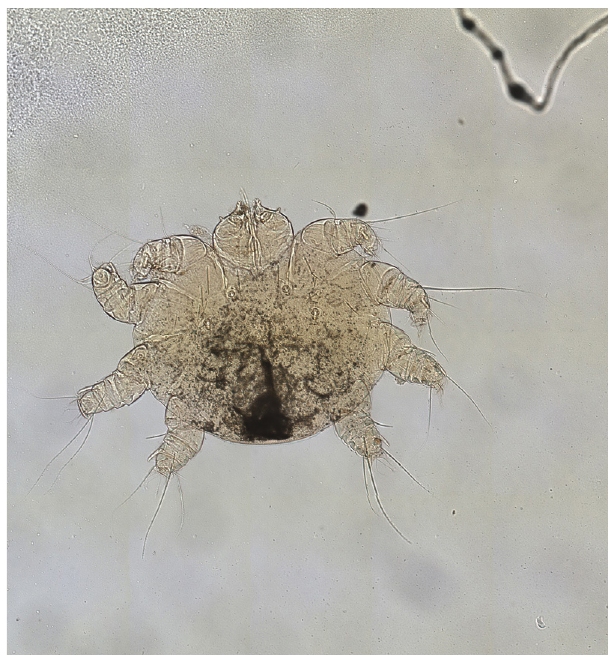
Fig. 2.14. Picture of a quickly composed image of a mite at 20×